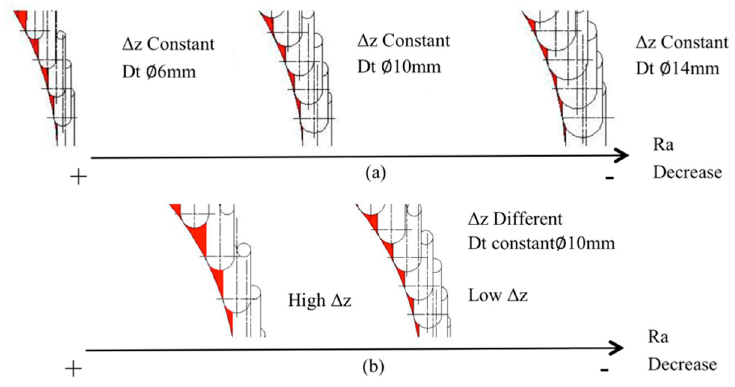
Figure 3. ( a ) Effect of different tool diameters, Dt, on surface roughness, Ra ( b ) Effect of different step down, Δ z, on surface roughness, Ra.